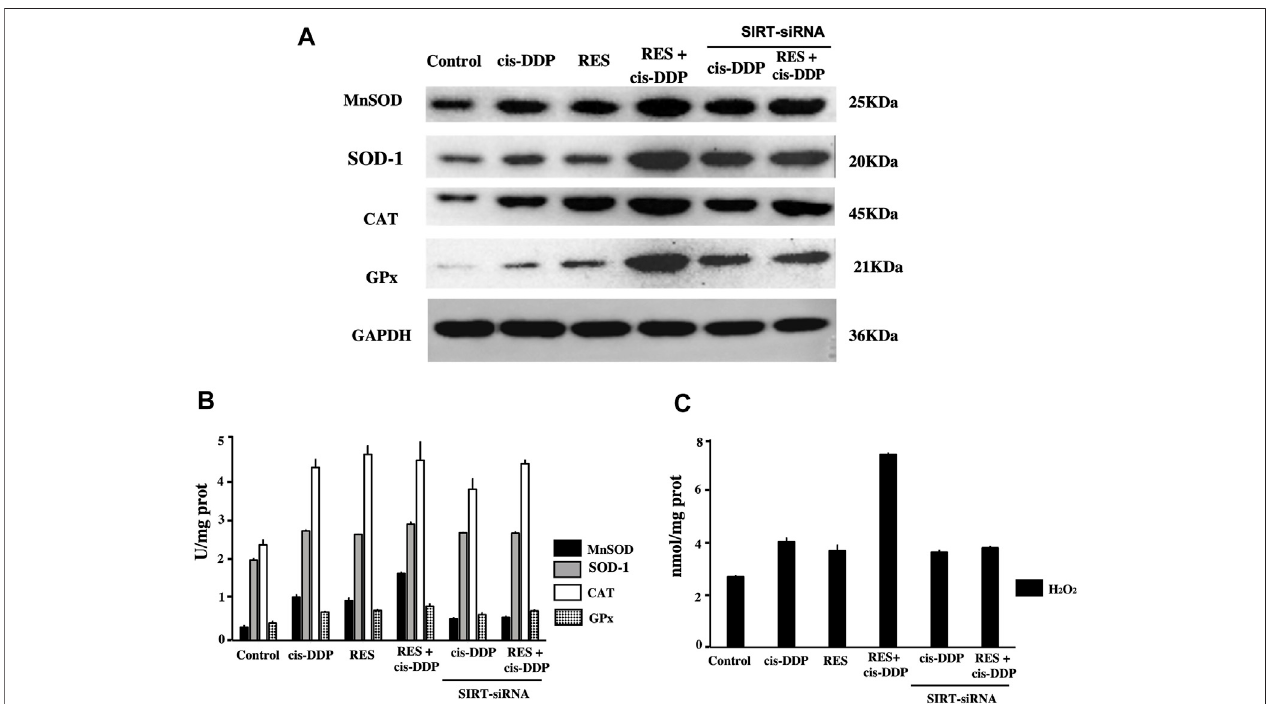
FIGURE 4 | RES + cis-DDP combination enhanced the expression and activation of antioxidant enzymes and increased the intracellular H 2 O 2 ; silencing of the SIRT3 gene decreased the MnSOD expression and intracellular H 2 O 2 in the RES + cis-DDP group. (A) Expression of antioxidant enzymes (MnSOD, SOD-1, CAT, and GPx) in each group was evaluated by Western blotting. RES + cis-DDP enhanced the expressions of MnSOD, SOD-1, CAT, and GPx compared with other groups ( p < 0.05),andSIRT3interferencesigni fi cantlydecreasedtheMnSODexpressionsintheRES+cis-DDPgroup( p < 0.01);SOD-1,CAT,andGPxwaslessimpactedby SIRT3silence. (B) Antioxidantenzymeactivitieswereevaluatedineachgroup,andsilencingofSIRT3wasperformedinthecis-DDPalonegroupandtheRES+cis-DDP group. (C) H 2 O 2 content in each group was evaluated, and silencing of SIRT3 was performed in the cis-DDP alone group and the RES + cis-DDP